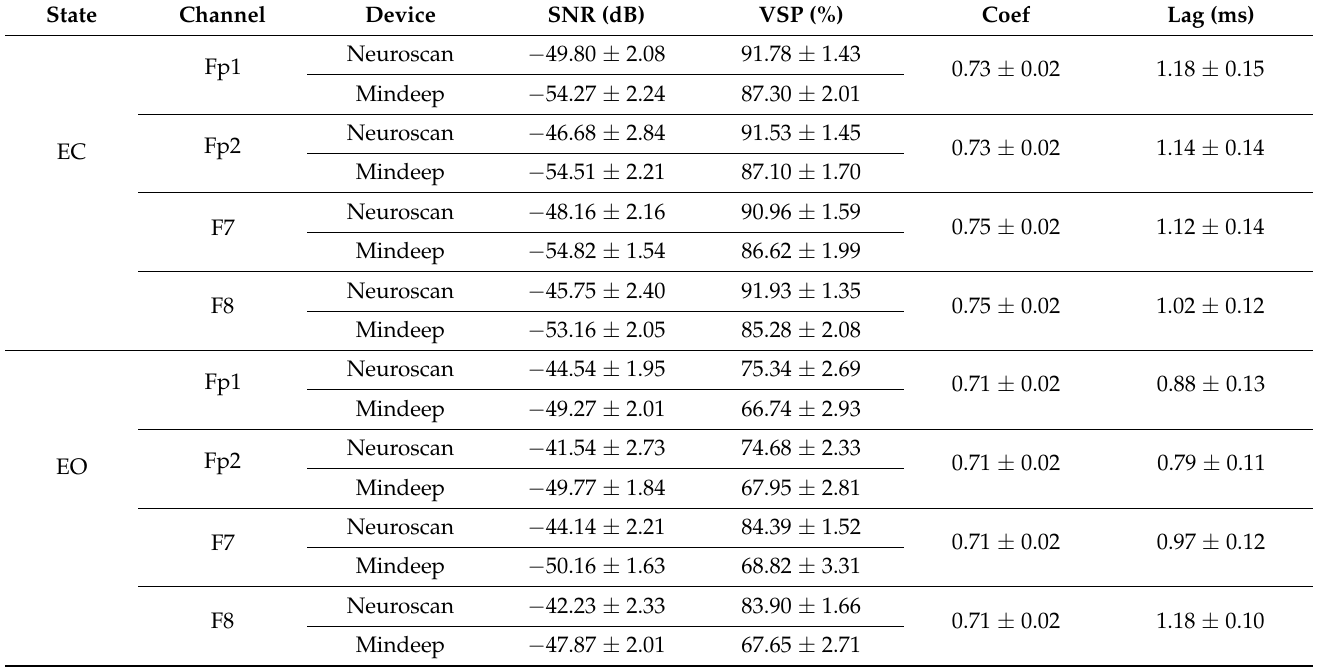
Table 2. SNR, VSP, and normalized cross-correlation coefficients for Neuroscan and Mindeep on all channels in EC and